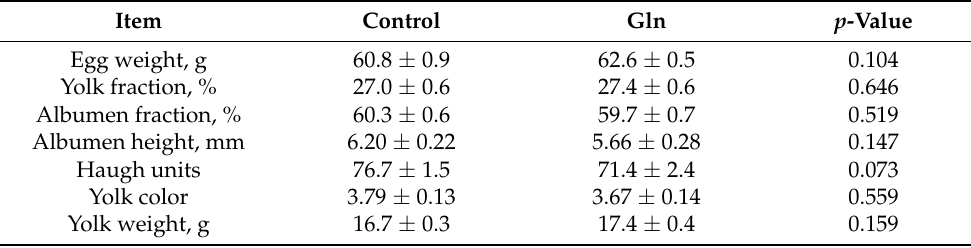
Table 2. The effect of dietary L-glutamine (Gln) supplementation (1.0%) on albumen and yolk indices of eggs from laying Bovans Brown hens at the end of a 30-week-long supplementation period (31st–60th wks of